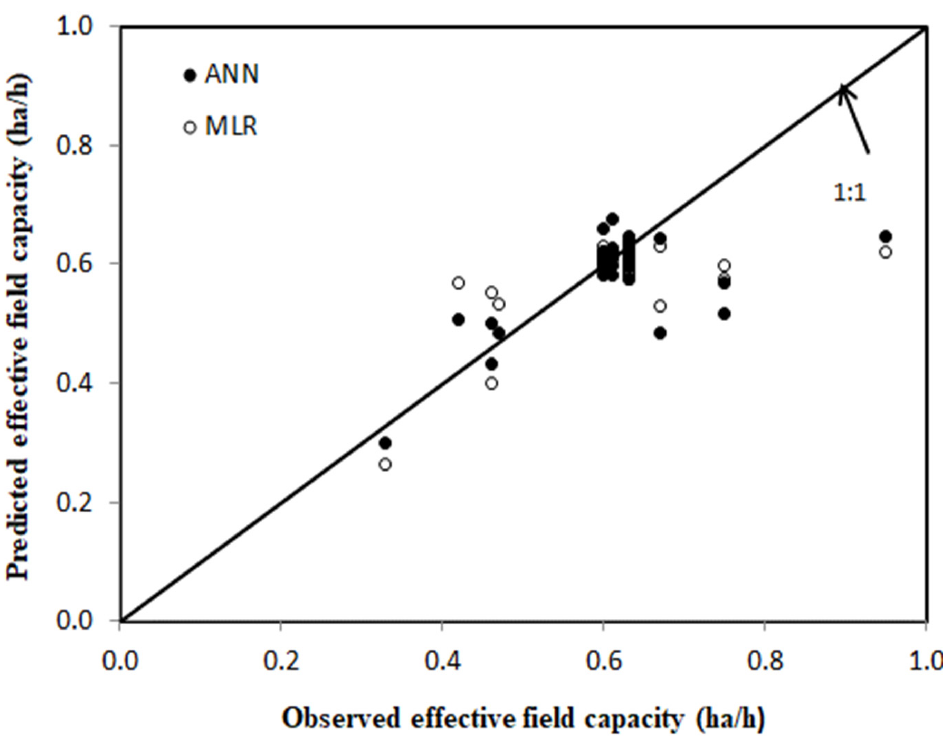
Figure 7. Correlation between the observed and predicted values for the effective field capacity of the MLR and ANN models in the case of the testing dataset.